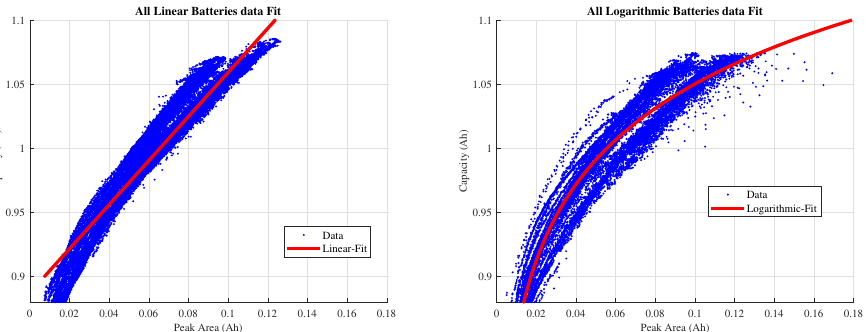
Figure 8. Linear ( left ) and logarithmic ( right ) models applied to all the first-life data of Set A and Set B.